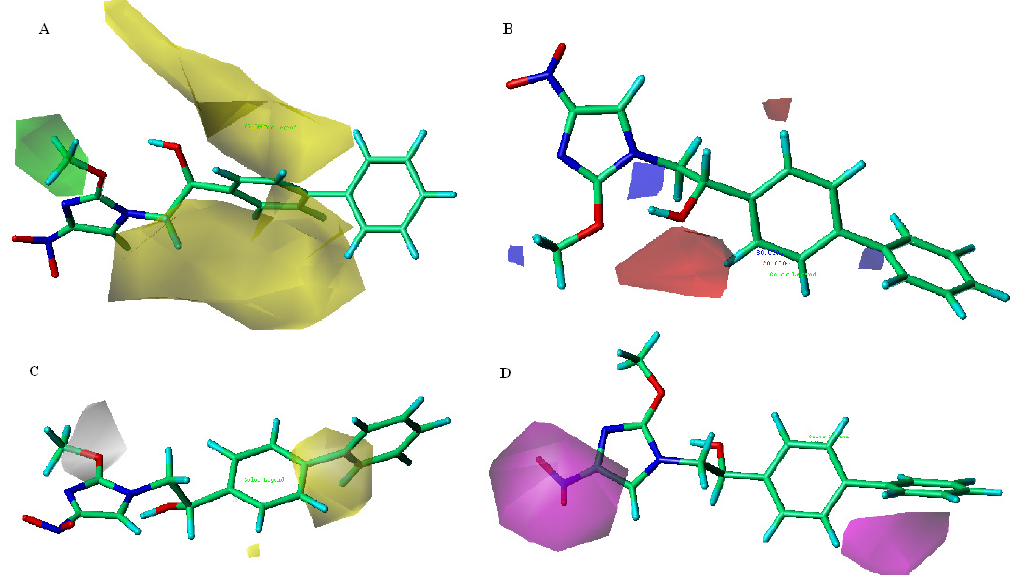
Figure 5. Contour plots with the combination of compound 15 for CoMSIA model IC; ( A ) Steric contour map. Green polyhedrons indicate regions where bulky groups increase activity; Yellow polyhedrons indicate regions where bulky groups decrease activity; ( B ) Electrostatic contour map. Red polyhedrons indicate regions where negative charges increase activity; Blue polyhedrons indicate regions where positive charges increase activity; ( C ) Hydrophobic contour map. Yellow polyhedrons indicate regions where hydrophobic substituent enhances activity; Gray polyhedrons indicate regions where hydrophobic groups decrease activity; ( D ) H-bond acceptor contour map. Magenta polyhedrons indicate regions where H-bond acceptor substituent increases